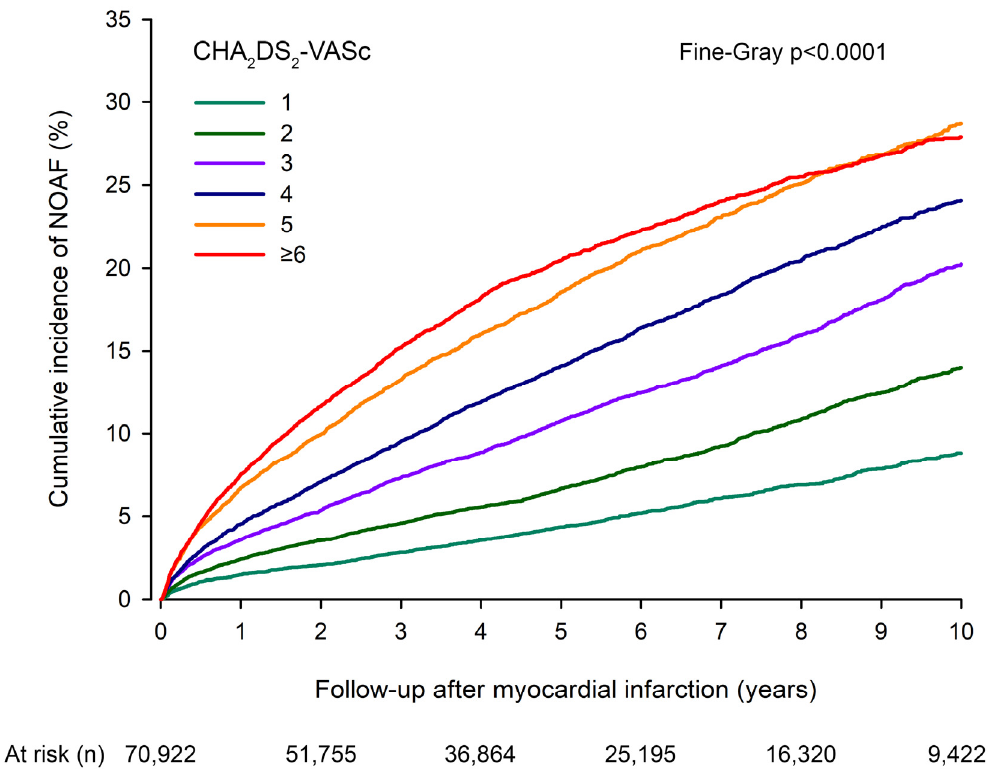
Figure 1. Cumulative incidence of new-onset atrial fibrillation (NOAF) after myocardial infarction by CHA2DS2-VASc score. Table 2. Cumulative incidence of new-onset atrial fibrillation after myocardial infarction at one- and ten-year follow-ups by baseline CHA 2 DS 2 -VASc score.